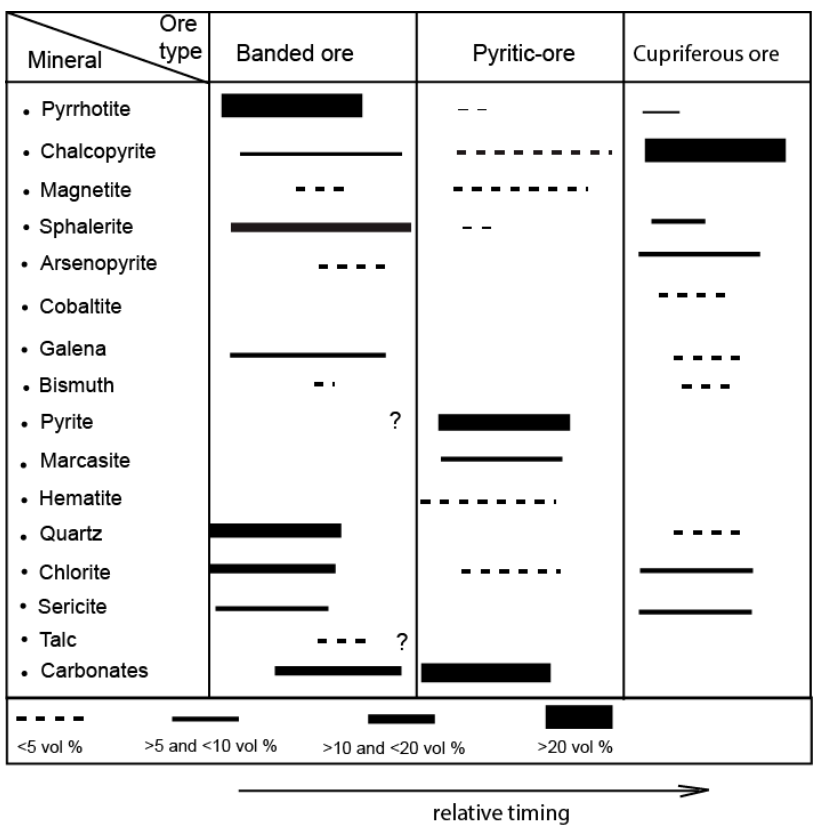
Figure 5. Paragenetic evolution of the main phases of mineralization in the MMSD.